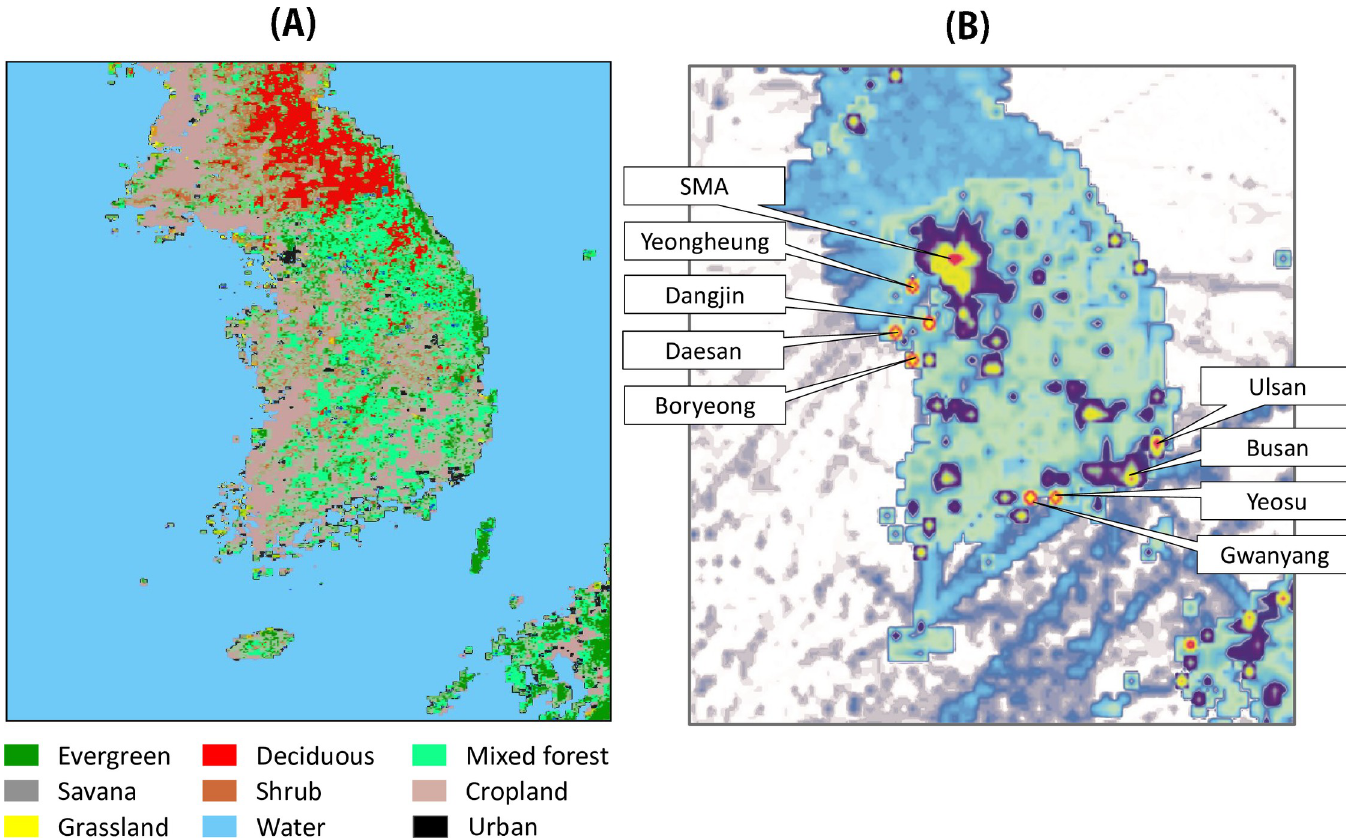
Fig 2. Spatial distribution of (a) land cover retrieved from SYNMAP and (b) anthropogenic emission from FDDA emission data in the finest domain. The ranges of anthropogenic emissions are displayed in S1 Fig. Names in square boxes indicate top 9 highest emission areas in Korea.